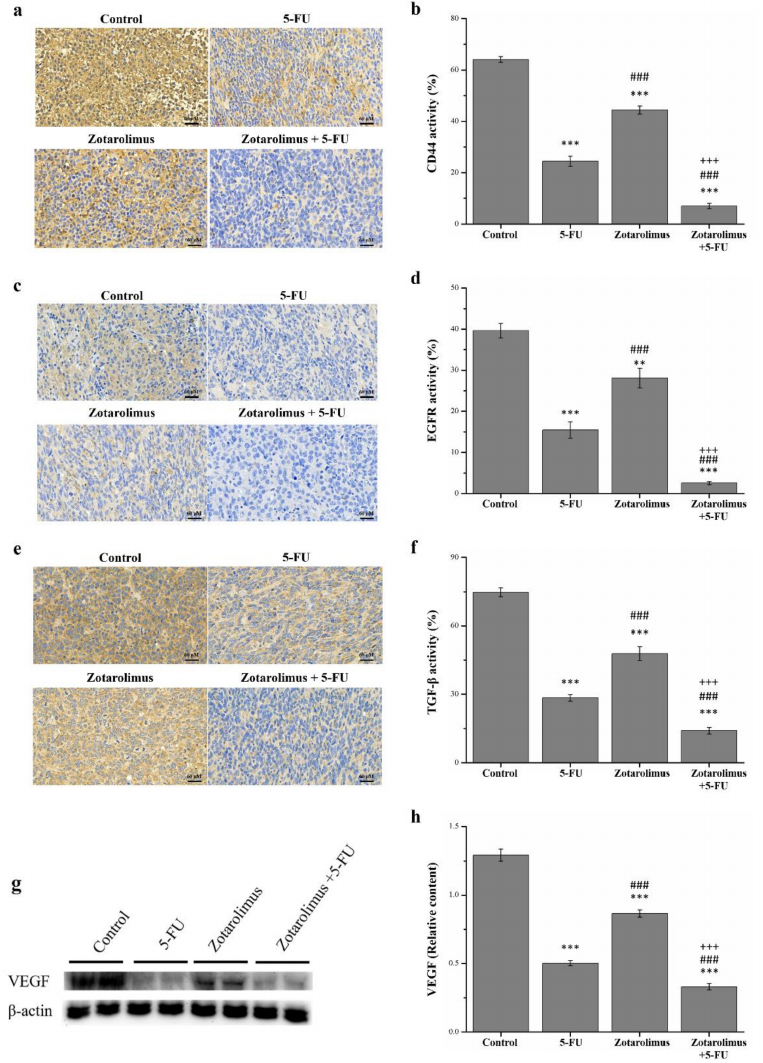
Figure 5. Immunohistochemical expression of ( a ) CD44, ( c ) EGFR, and ( e ) TGF- β , and a comparison of ( b ) CD44, ( d ) EGFR, and ( f ) TGF- β expression levels. Western blot analysis ( g ) showing the expression of metastasis-related factors extracted from tumors in a representative blot. Expression of ( h ) VEGF in the HCT-116 tumor masses from BALB/c nude mice in the control groups and mice administered different treatments, including 5-FU (50 mg/kg/week), zotarolimus (2 mg/kg/day), and a combination of zotarolimus (2 mg/kg/day) and 5-FU (50 mg/kg/week). All data are presented as mean ± standard deviation, n = 8 per group. ** p < 0.01 and *** p < 0.001 compared with the control group. ### p < 0.001 compared with the 5-FU-treated group. +++ p < 0.001 compared with the zotarolimus-treated group. Scale bars = 60 µ